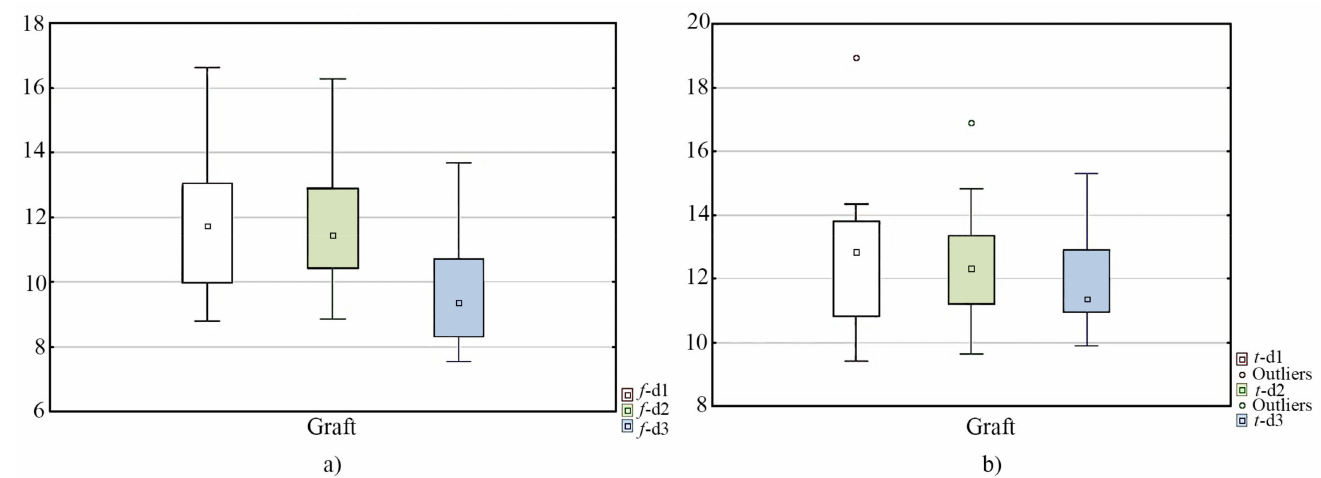
Figure 5. Boxplots showing the measurements of the diameter of ( a ) the femoral bone tunnel at three parts of tunnel: f -d1—entrance, f -d2—midportion, and f -d3—exit; ( b ) the tibial bone tunnel at three parts of tunnel: t -d1—entrance, t -d2—midportion, and t -d3—exit. Boxplot legend: the median is shown as a square in the center of the box. The top and bottom of the boxes represent the first and third quartiles, respectively. The whiskers correspond to the maximal and minimal values within the 1.5 × interquartile range (IQR). The outliers are plotted as